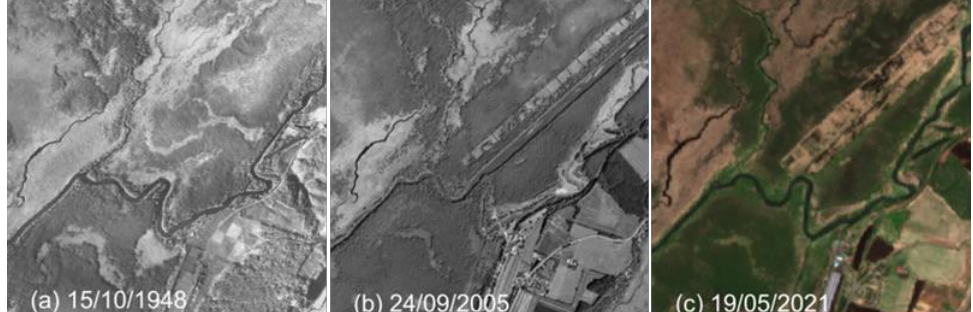
Figure 2. Historical changes in the study site of Kushiro Wetland from aerial images. These aerial images cover 2 km square centered at 43°12 ′ N, 144°30 ′ E (( a ): 15 October 1948, ( b ): 24 September 2005, Source: modified from the image in Geospatial Information Authority of Japan [55]), (( c ): 19 May 2021, Source: modified from the image in Google Earth Engine [56]).